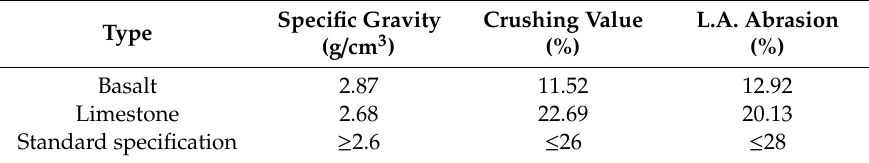
Table 2. Physical properties of basalt and limestone